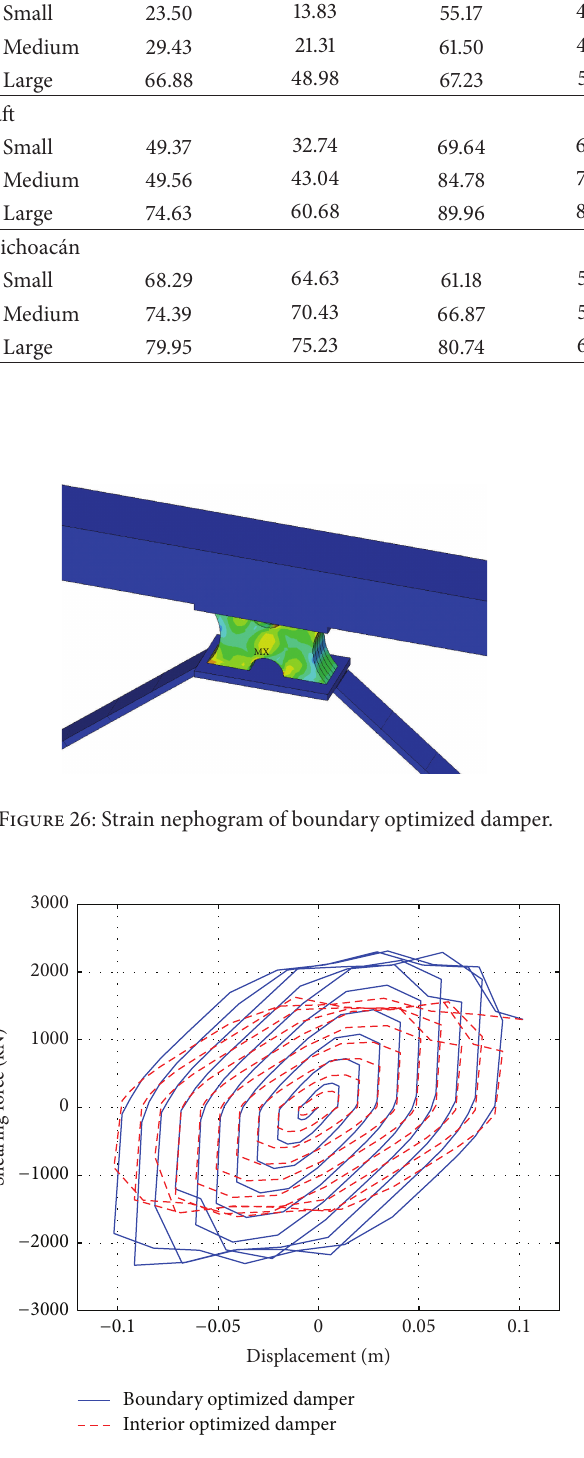
Figure 27: Hysteretic curves of damper.